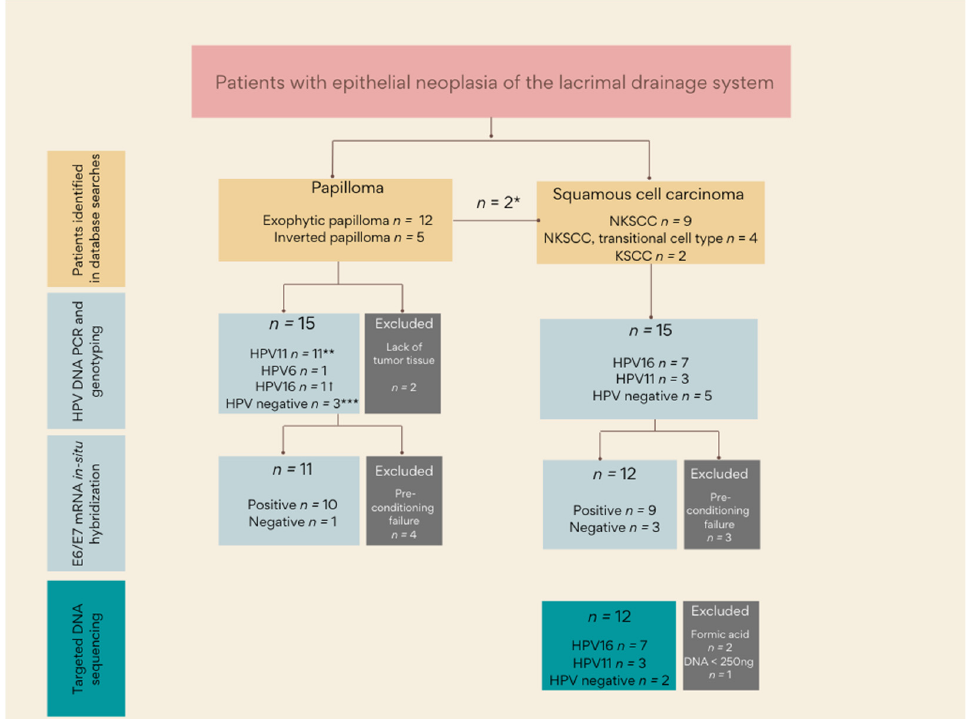
Figure 1. An overview of the workflow for HPV analyses and DNA sequencing. * Malignant transformation occurred in two patients with an LDS papilloma. ** One sample had concurrent infection with HPV11 and 16. ***The HPV-negative papillomas included two exophytic papillomas and one inverted papilloma.